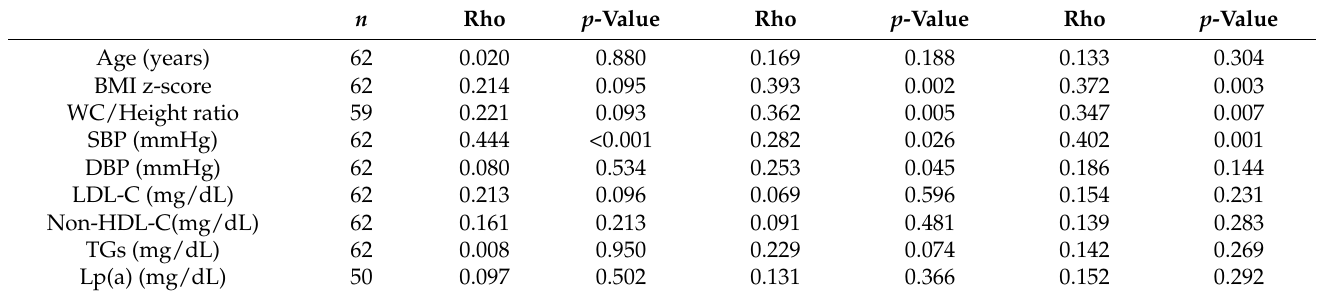
Table 3. Correlations of cIMT with clinical or laboratory quantitative parameters (Spearman’s rho).